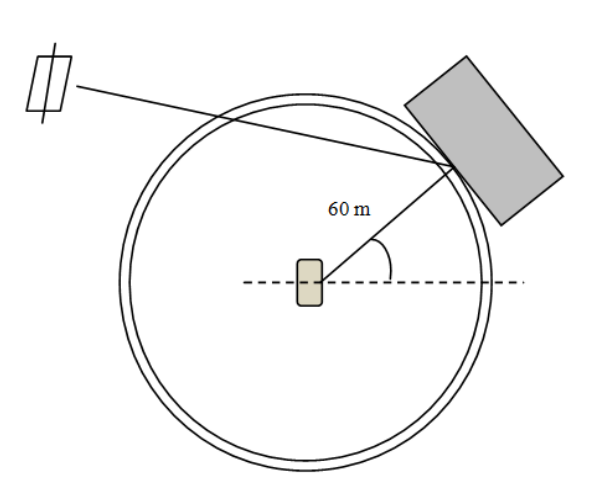
Figure 12. Description of multipath estimation